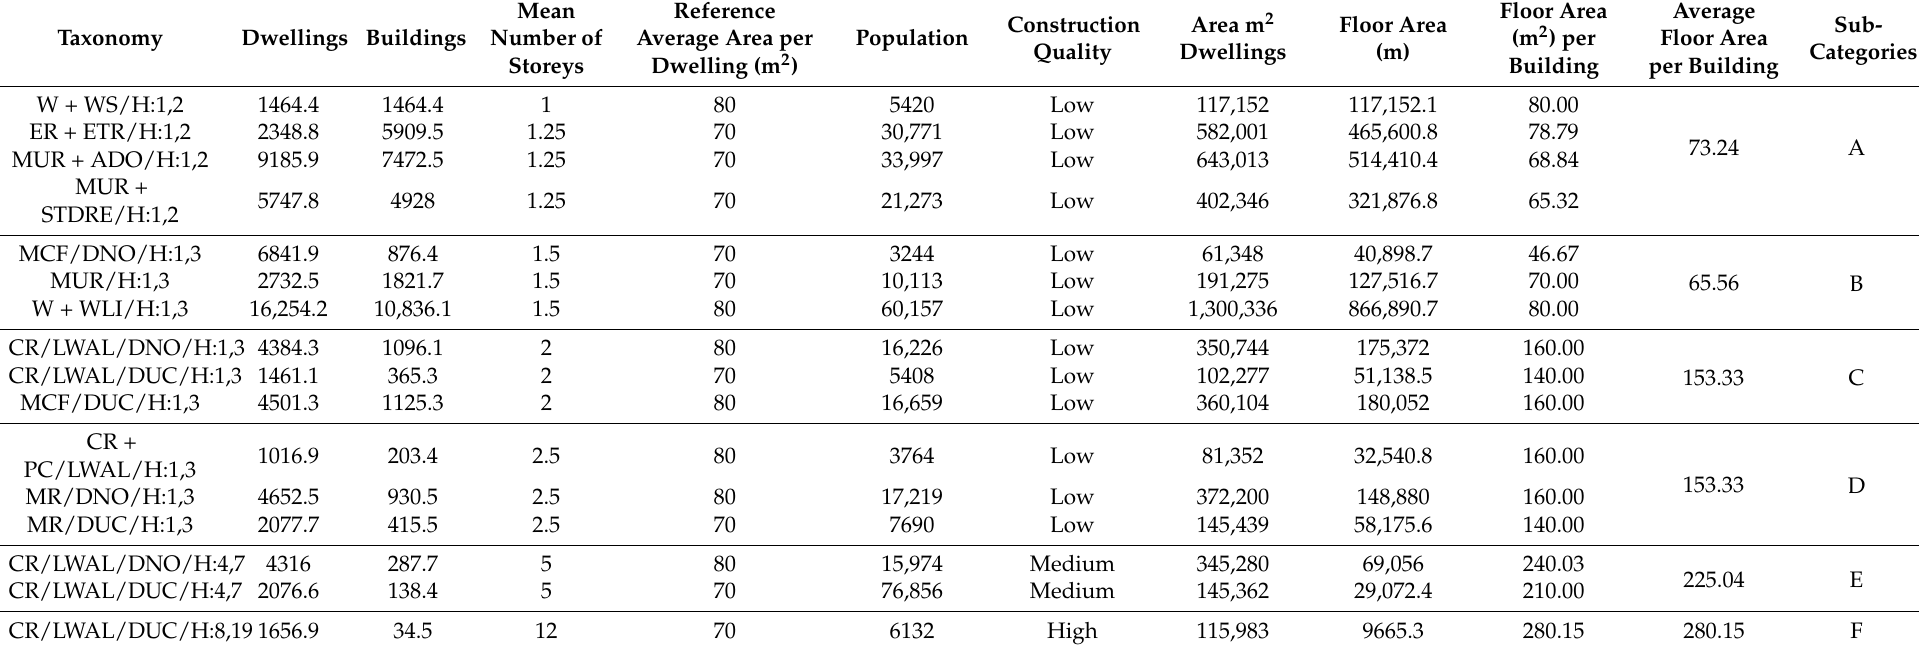
Table A1. Procedure followed in deriving the building footprint area values for each SARA typology in Valpara í so according to the descriptions in Section